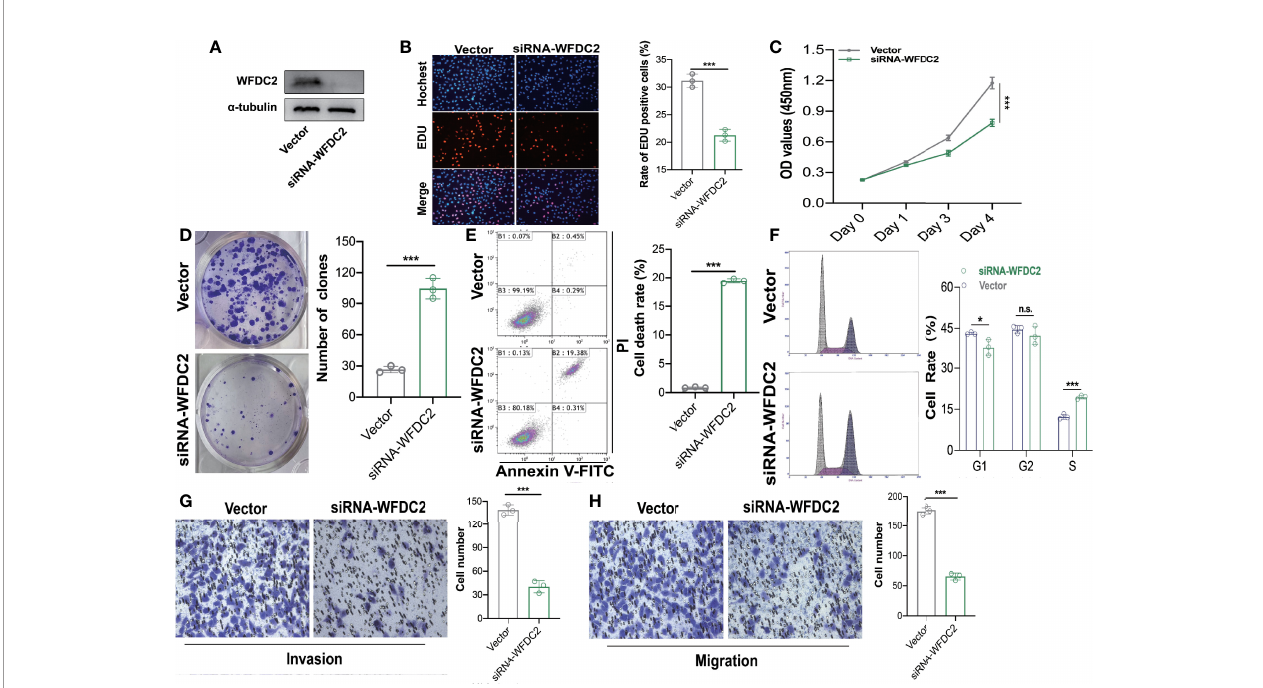
FIGURE 8 | WFDC2 downregulation inhibited proliferation, migration, and invasion while enhanced apoptosis in A549 cells. (A) Expressions of WFDC2 inA549 cells transfected with or without siWFDC2 were detected by Western blot. (B) EdU assay was performed to detect the proliferation of A549 cells transfected with or without siWFDC2. (C) CCK-8 assay was performed to detect the proliferation of A549 cells transfected with or without siWFDC2. (D) Colony formation assay was performed to detect the proliferation of A549 cells transfected with or without siWFDC2. (E) Cell apoptosis of A549 cells transfected with or without si-WFDC2 was examined by Annexin V-FITC/PI-labeled fl ow cytometry. (E) Representative cell-cycle distribution pro fi les of WFDC2 inhibited 549 cells. (F) Transwell assay was performed to detect the migration and invasion of A549 cells transfected with or without si-WFDC2. n = 3, *p < 0.05,**p < 0.01,***p <